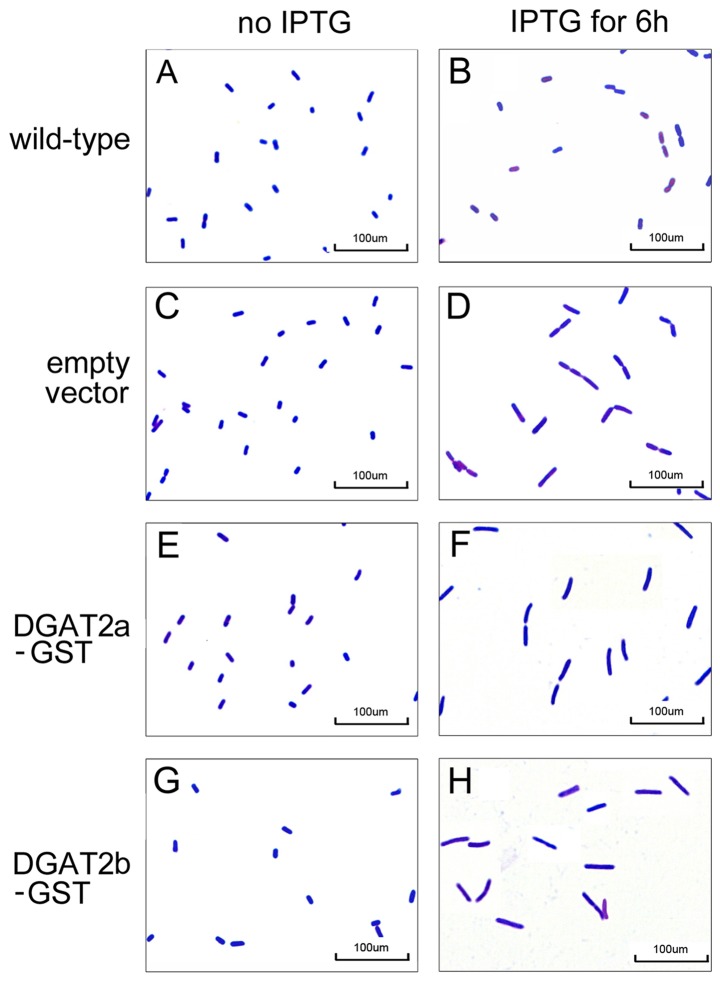
Morphology of wild type and transformed E. coli before and 6 h after the addition of IPTG into the growth medium.Cells were sampled and Gram stained before induction (A, C, E, G) and 6 h after induction (B, D, F, H). (A, B) wild-type E. coli cells; (C, D) empty-vector transformed cells; (E, F) AhDGAT2a–GST vector transformed cells; (G, H) AhDGAT2b–GST vector transformed cells.